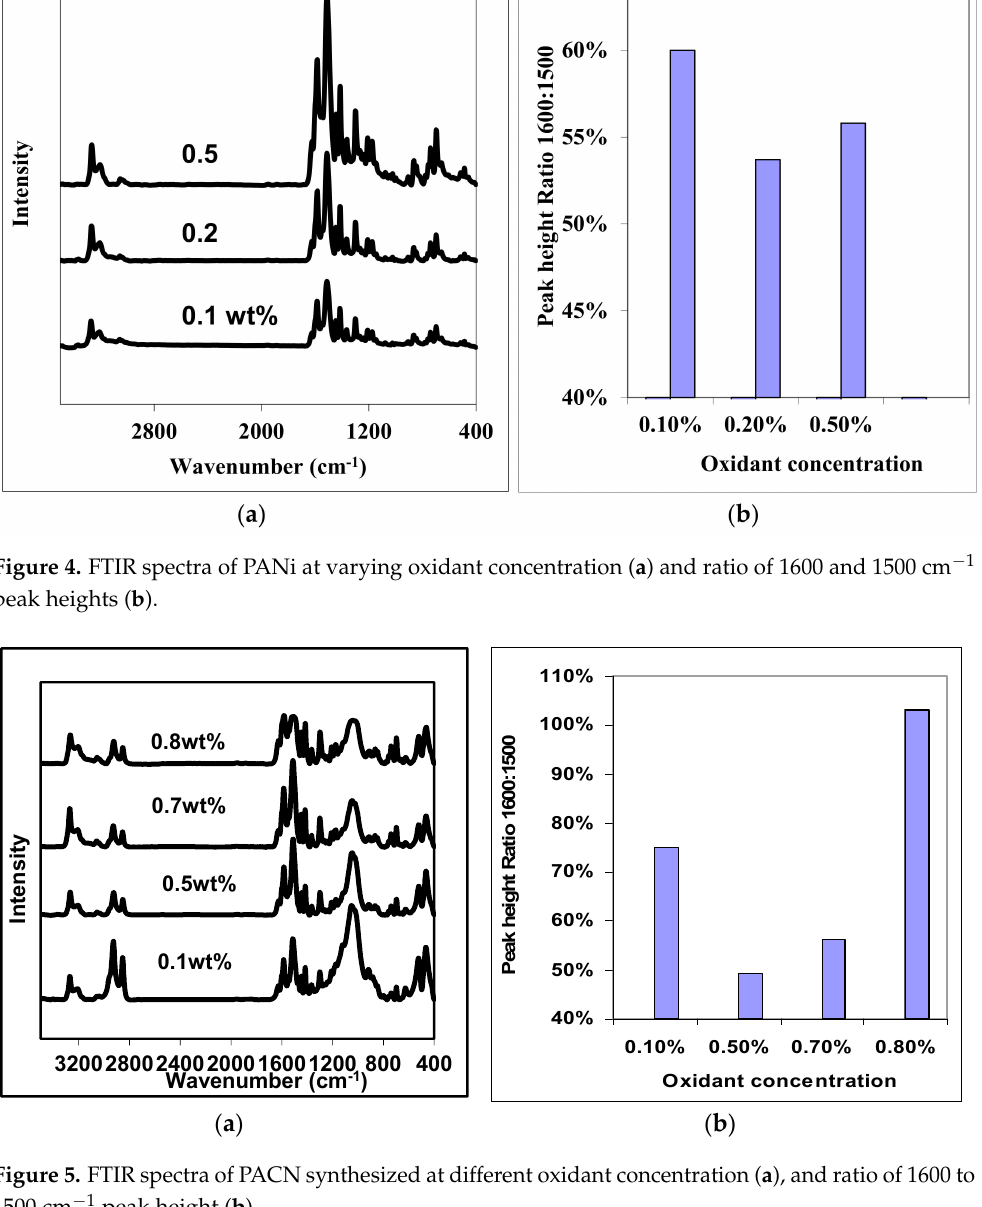
Figure 4. FTIR spectra of PANi at varying oxidant concentration ( a ) and ratio of 1600 and 1500 cm − 1 peak heights ( b ).